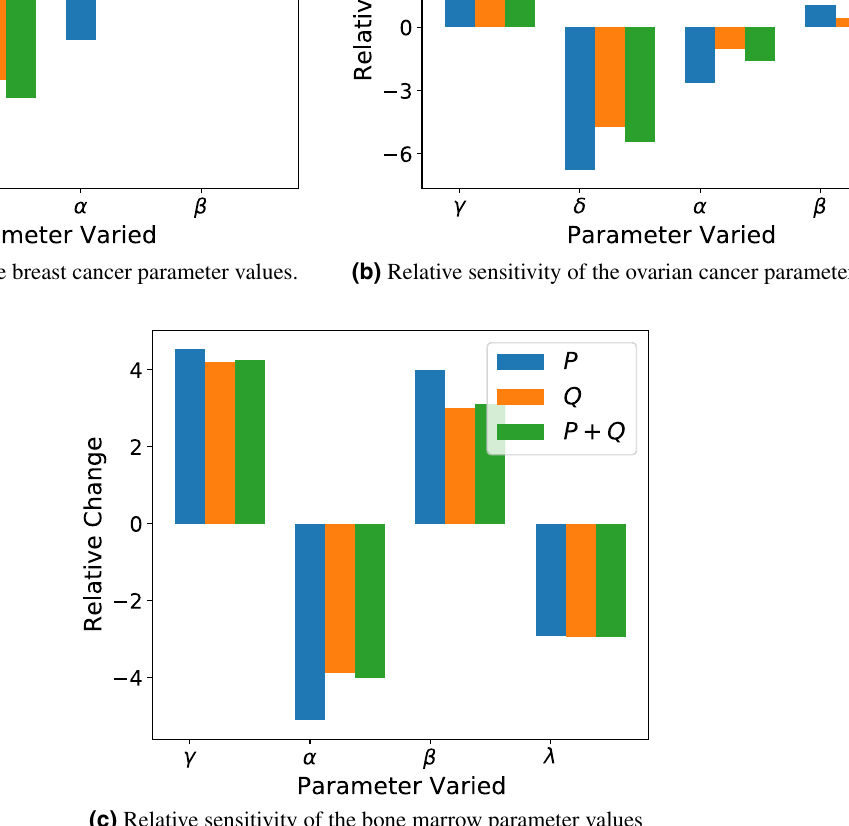
Figure 6. Relative sensitivity of Eq. (1) under the parameter sets from Table 1. Parameters with zero value ( δ for bone marrow and (cid:31) for breast and ovarian cancer) were ignored and not displayed in this